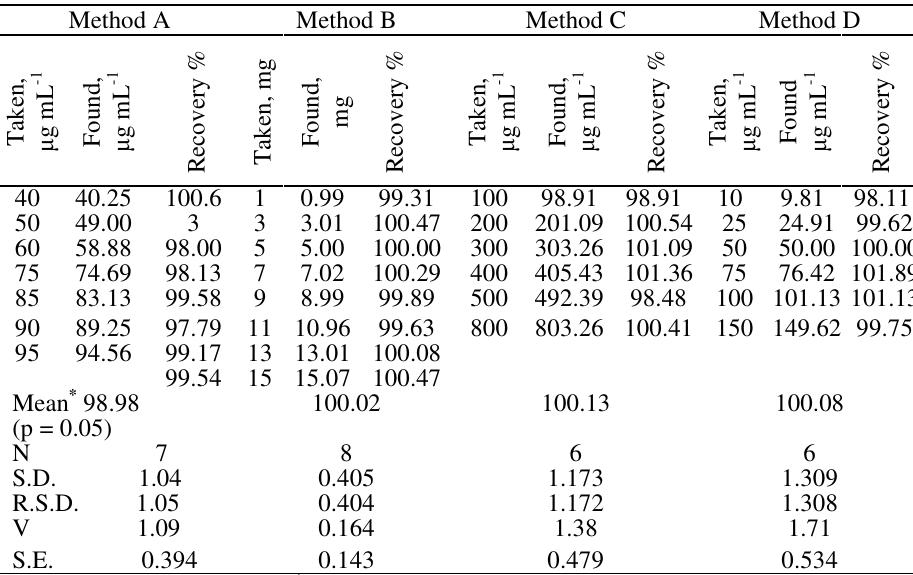
Table 2. Determination of gabapentin by using methods